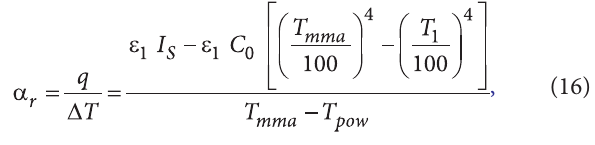
Fig. 1. The value of α coefficient of thermal penetration, depending upon the temperature of the air, the velocity of the wind and the width of the layer with the relative humidity φ = 80% and the density of the stream of sunshine radiation I S = 205 W/m 2 . Denominations: the first value – the air temperature in °C, the second value (behind the bottom line) – the width of the layer in m, for instance, 20 °C_3.5 m – the air temperature 20 °C, the width of the layer 3.5